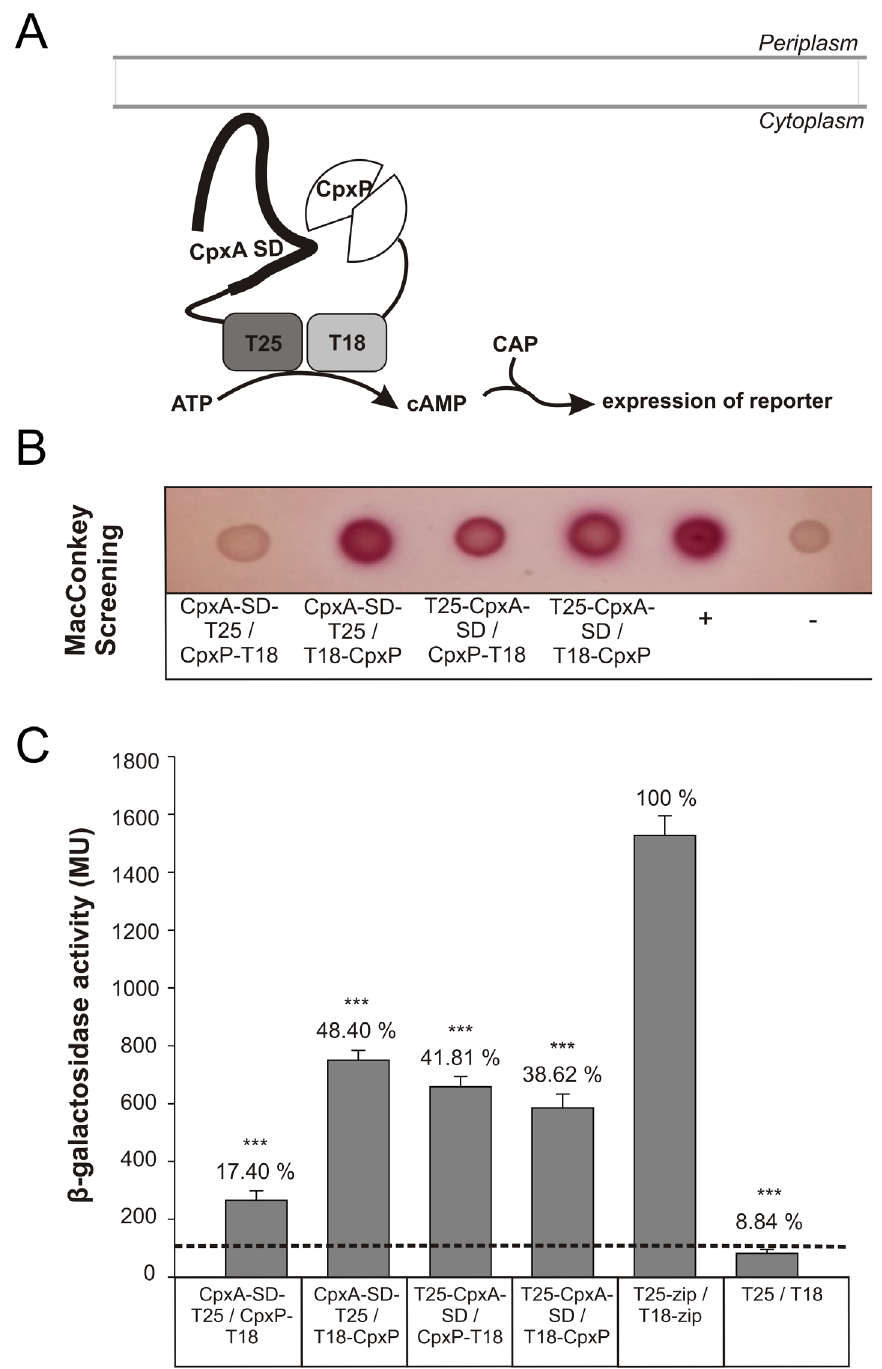
Figure 1. BACTH demonstrates physical interaction between CpxP and the periplasmic sensor domain of CpxA. For protein–protein interaction analysis using a bacterial two-hybrid system (BACTH) CpxP and the sensor domain of CpxA (CpxA-SD) were fused to the N- or C-terminal ends of the T25 and T18 fragments of B. pertussis adenylate cyclase as indicated. Strain BTH101 was co-transformed with plasmids encoding the different T25- and T18-hybrid proteins. T25- and T18-fragments fused to the leucine zipper of transcription factor GCN4 and the empty vectors served as positive ( + ) and negative ( 2 ) controls. (A) Illustration of functional complementation of CyaA fragments by BACTH. Interaction between two hybrid proteins in the cytosol results in functional complementation between the T25 and T18 fragments, resulting in cAMP synthesis. cAMP together with the catabolite activator protein (CAP) induces the expression of E. coli sugar catabolic operons, such as lactose and maltose. (B) 3 m l of a LB overnight culture were spotted on a MacConkey-Lactose plate and incubated for 24 h at 30 u C. (C) The degree of functional complementation between the indicated hybrid proteins was quantified by measuring ß-galactosidase activities in suspensions of toluene-treated E. coli BTH101 cells harboring the corresponding plasmids. The activity of the negative control (pKT25, pUT18C) represents the background (dashed line). Shown are the averages 6 S.E.M. of three biological replicates each in technical triplicates (t test). Numbers above bars give percentage of ß-galactosidase activity relative to the positive control.